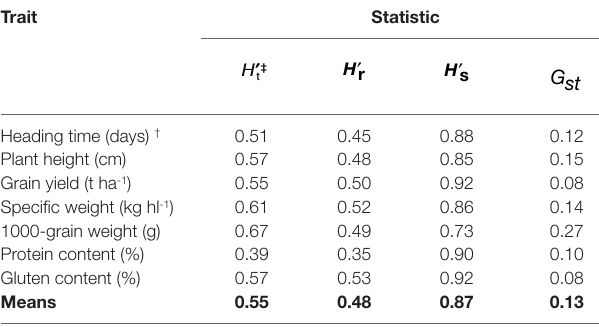
TABLe 3 | Phenotypic diversity index and partitioning within the four geographic regions of Africa, Asia, Europe, and others, based on the seven traits of the 77 Khorasan accessions.